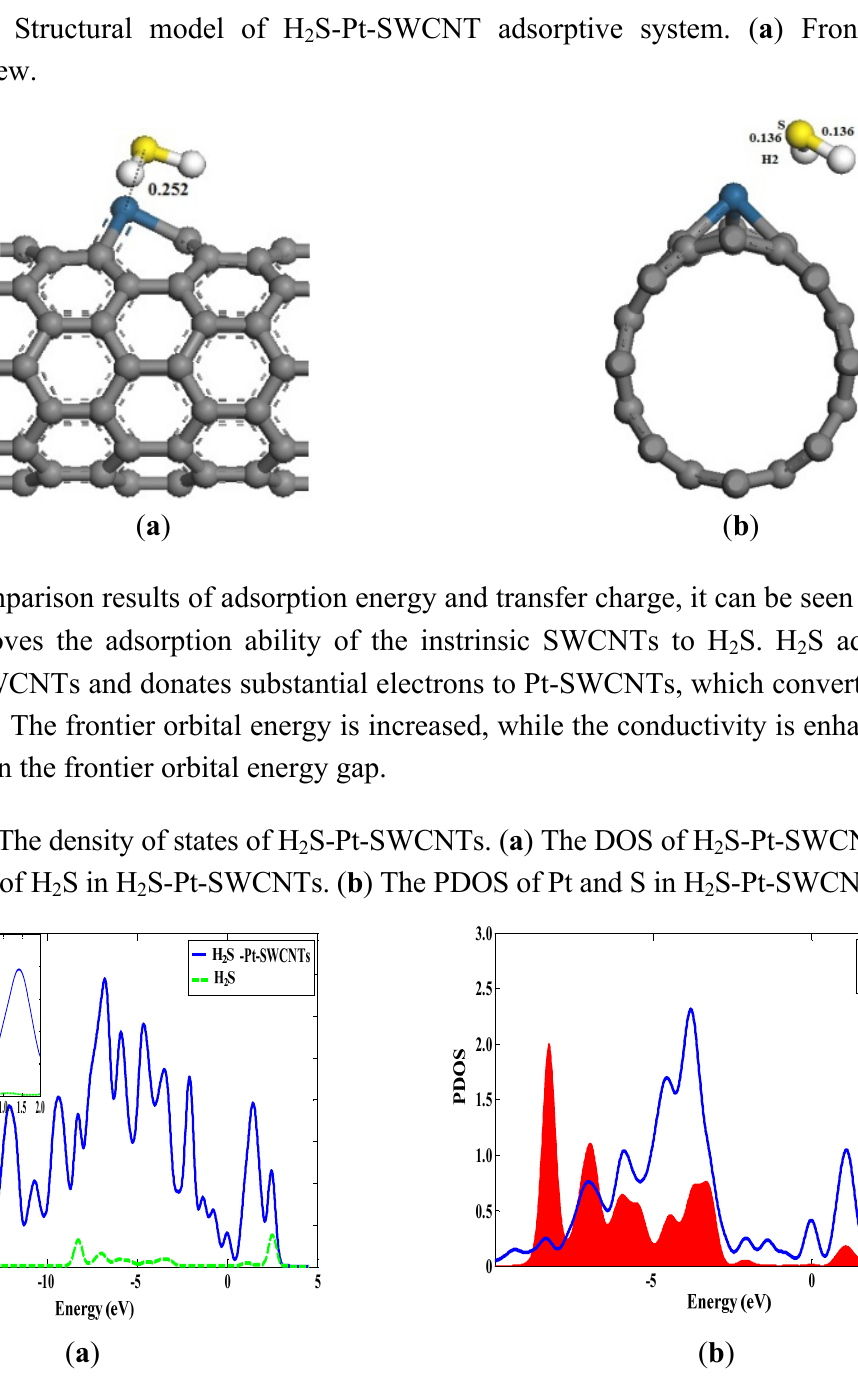
S-Pt-SWCNT adsorptive system. ( a ) Front view; 2